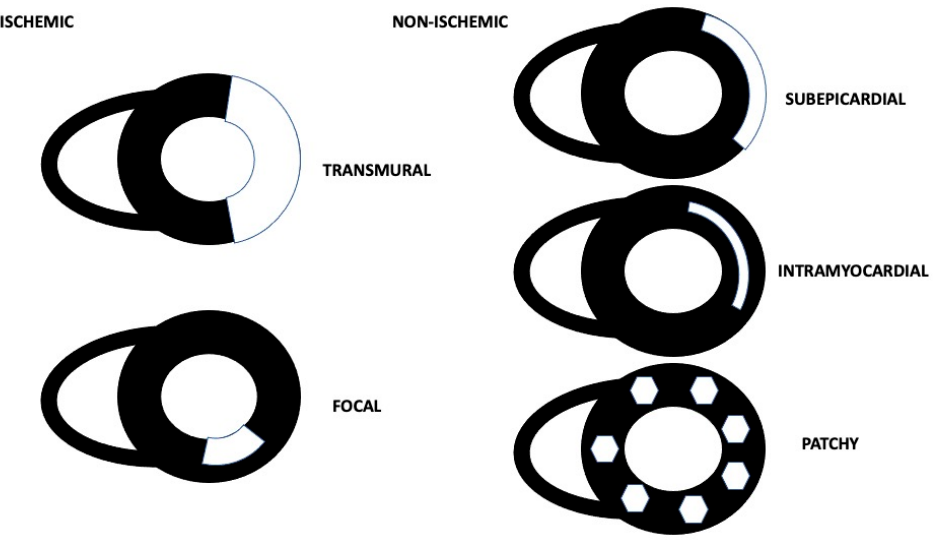
Figure 1. Ischemic and non-ischemic CMR LGE patterns.